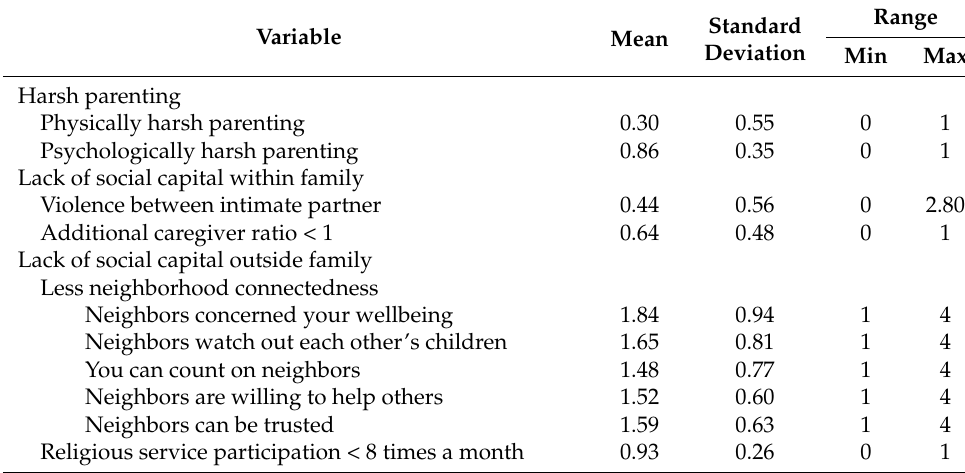
Table 1. Descriptive summary of model variables (N =